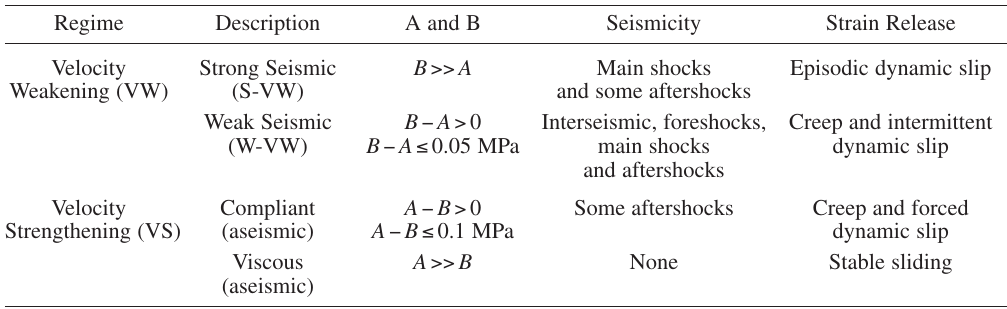
Table I. Frictional behaviors proposed by Boatwright and Cocco (1996). A = a σ n eff and B = b σ n eff